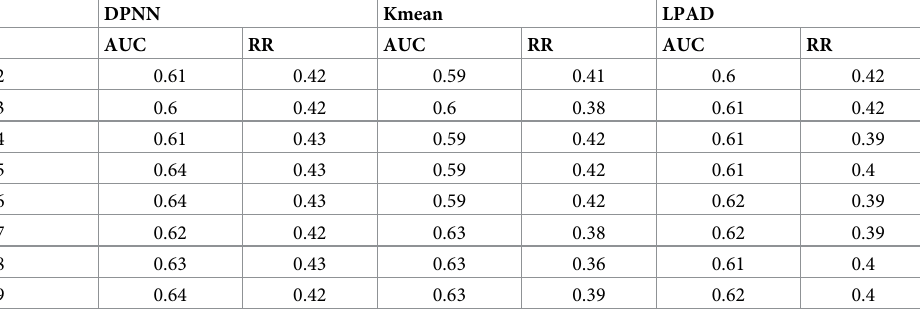
Table 8. Sensitivity analysis- MDD data. Performance by Number of